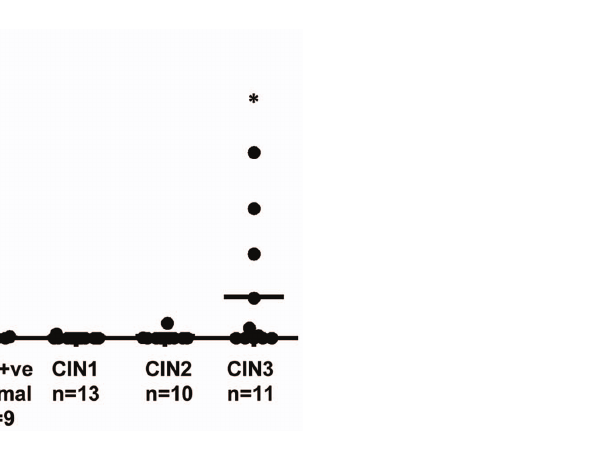
Fig. 3. Cervical samples from women with CIN3 have increased numbers of TRA-1-60 + ve cells detected by flow cytometry (see Materials and Methods for details), 1 way ANOVA (Kruskall Wallis test with Dunn’s post-test versus HPV + ve normal group), * 5 p ,